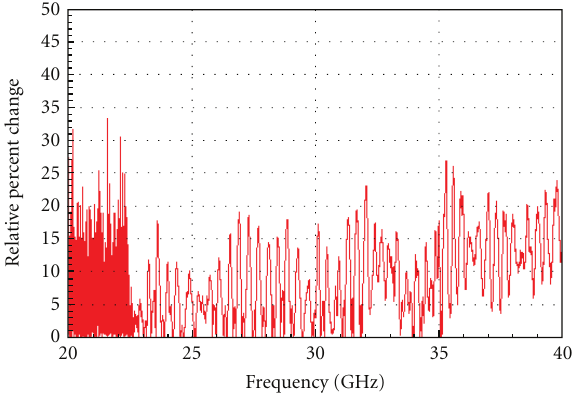
Figure 7: Relative percent change of TiO 2 sample with reference to glass-only